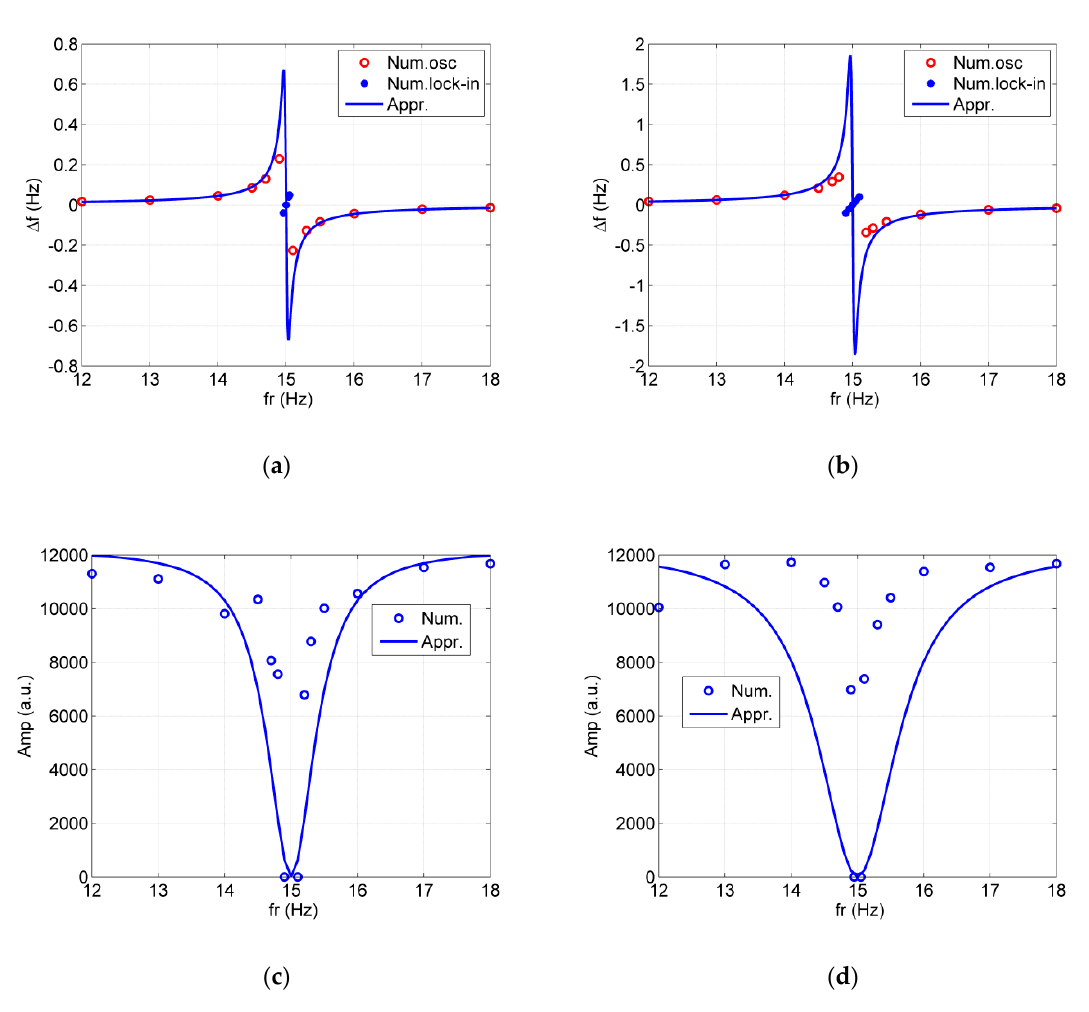
Figure 5. The frequency shift ∆ f and amplitude Amp of the spin oscillator vs. frequencies of the CARE